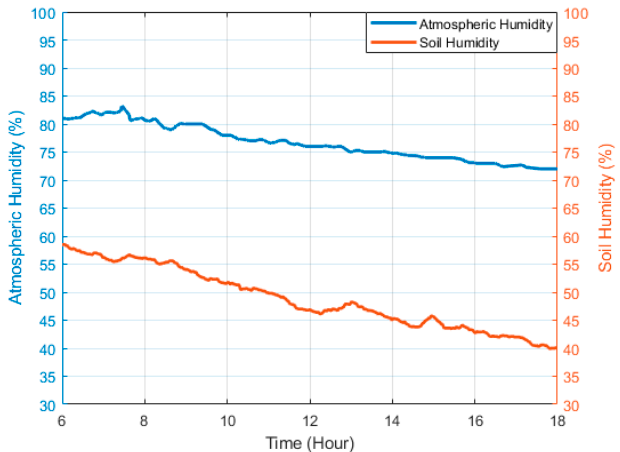
Figure 8. Atmospheric and soil humidity (%) evolution over time—Experimental test